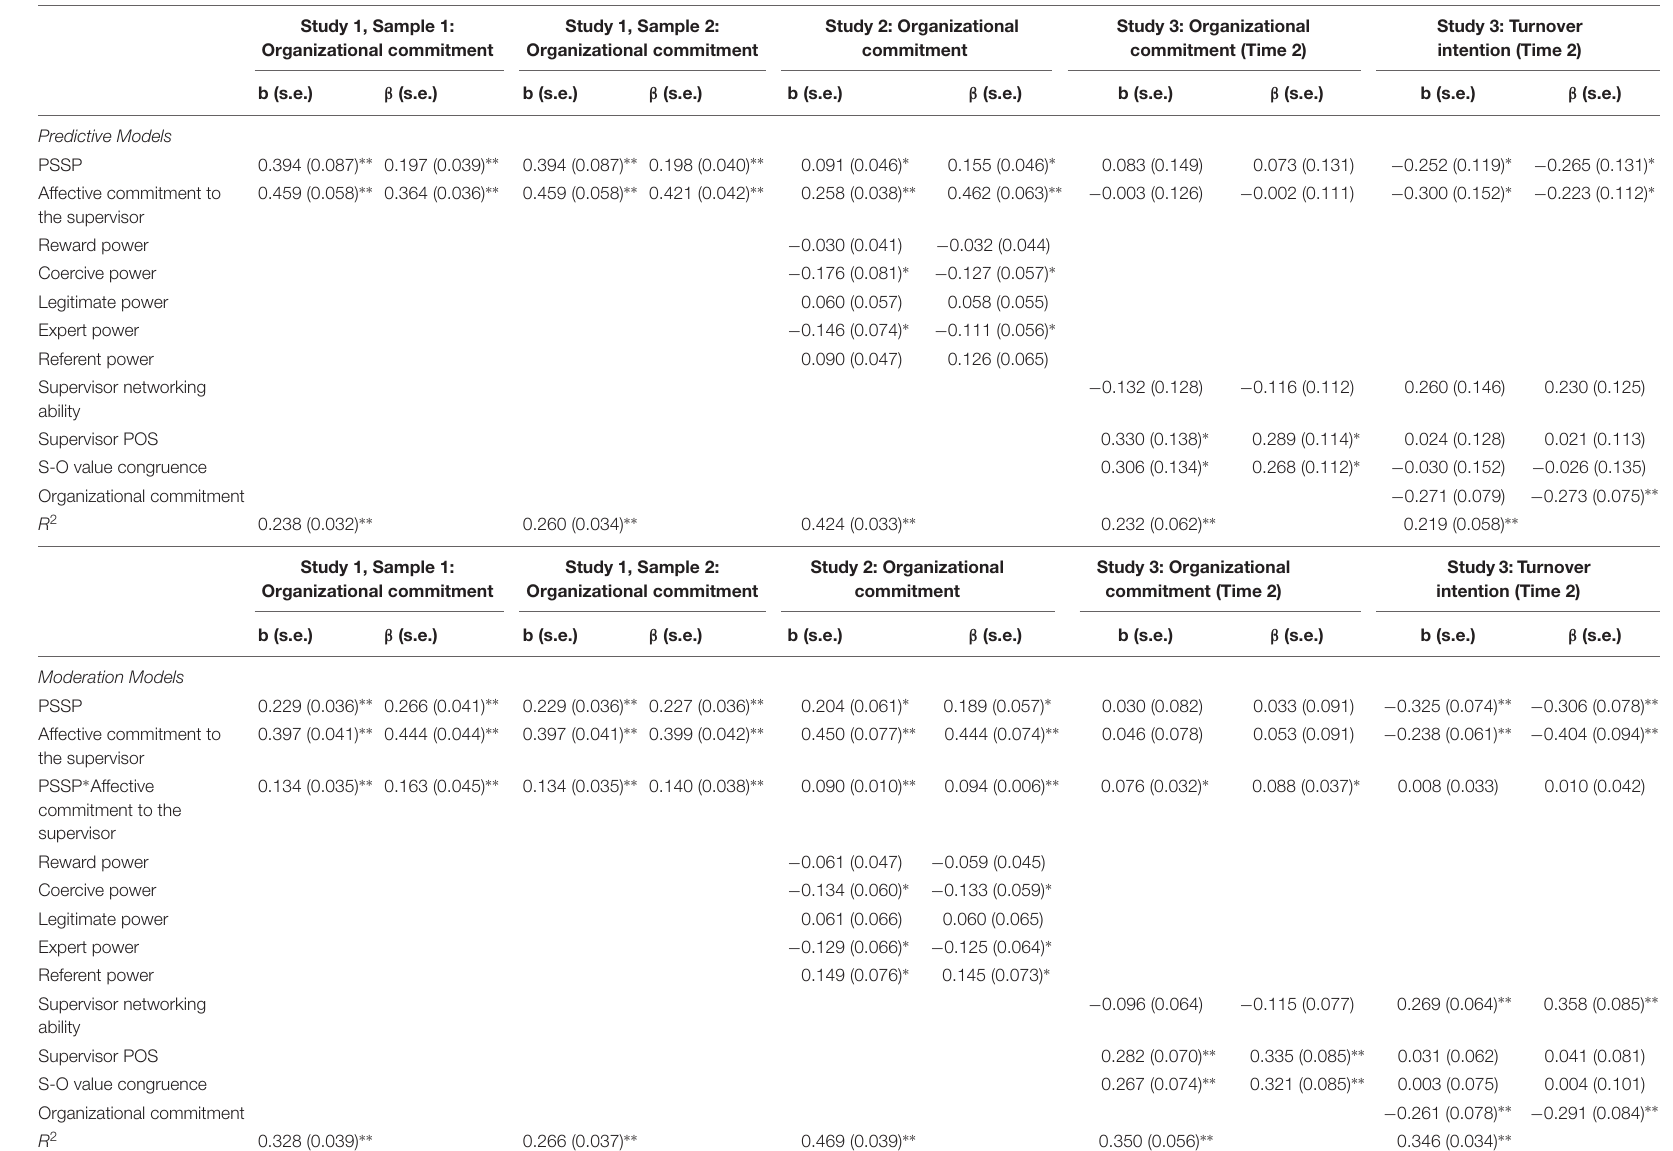
TABLE 5 | Predictive Model Results across Studies and